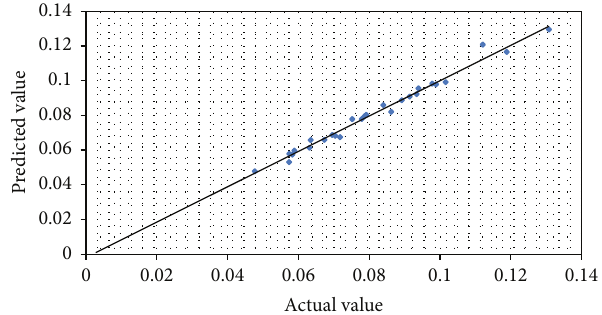
Figure 1: Correlation of the PLS terms with spectral data.